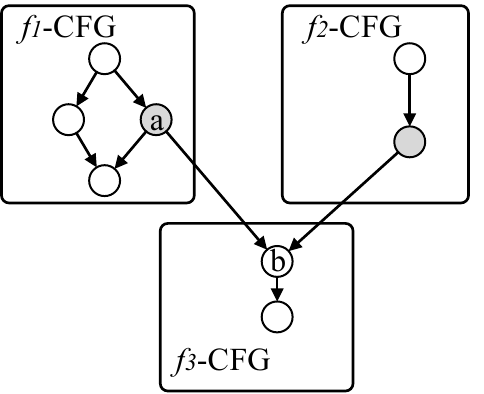
Figure 3. Example of the static inter-procedural control flow graph (iCFG)